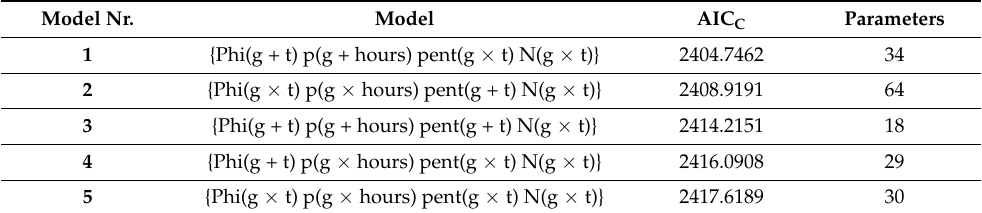
Table 1. Comparison of the best models of Popan 5.0 analyses for the estimates of the daily population size of Erebia pronoe : Akaike Information Criterion (AIC C ) and number of parameters used, basic variables: Probability of survival (Phi), probability of recapture (P), proportional recruitment (Pent), the total number of individuals (N), dependent variables: sex (g); factorial (t), linear (T) and quadratic (T2) dependence of time; time invested in sampling per day (hours).